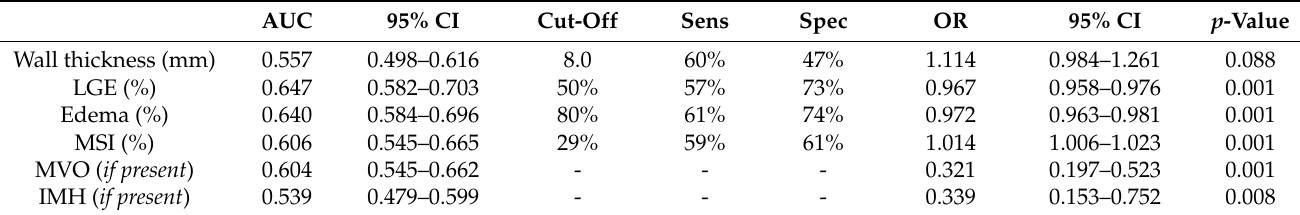
Table 3. Conventional CMR and prediction of functional recovery at